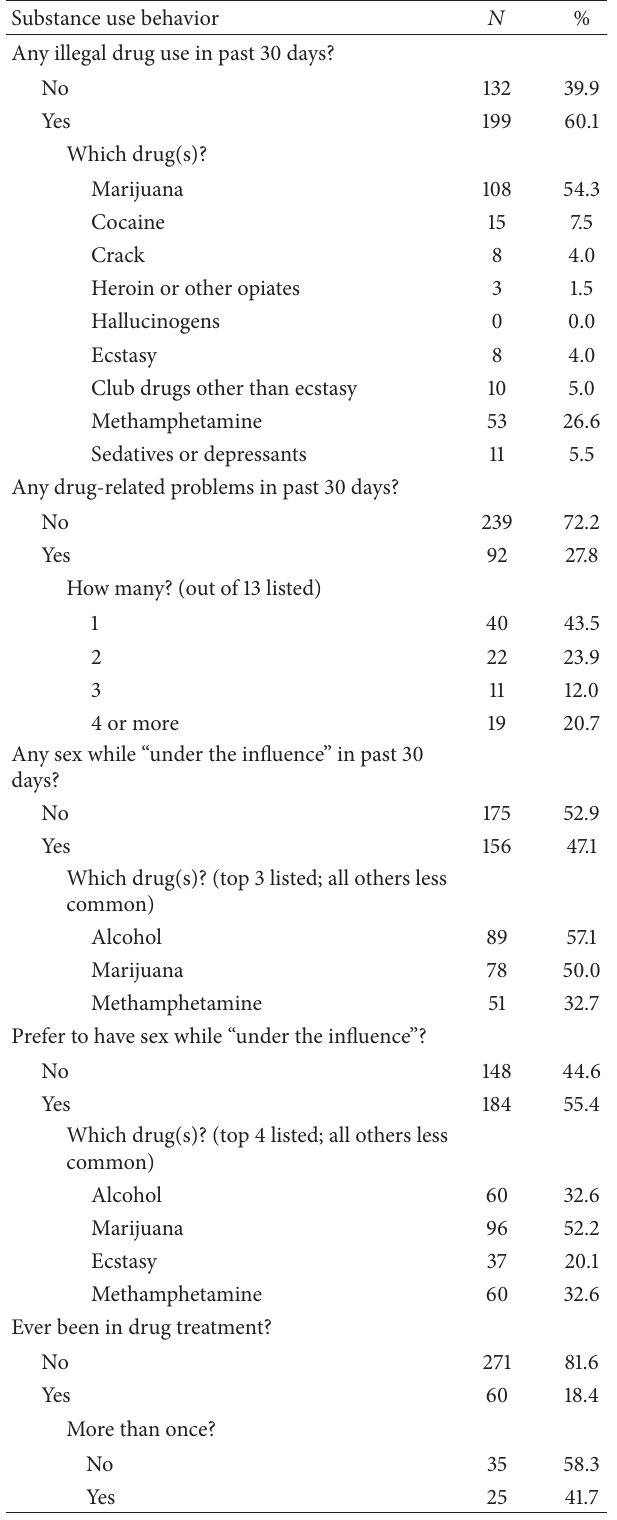
Table 4: Substance use